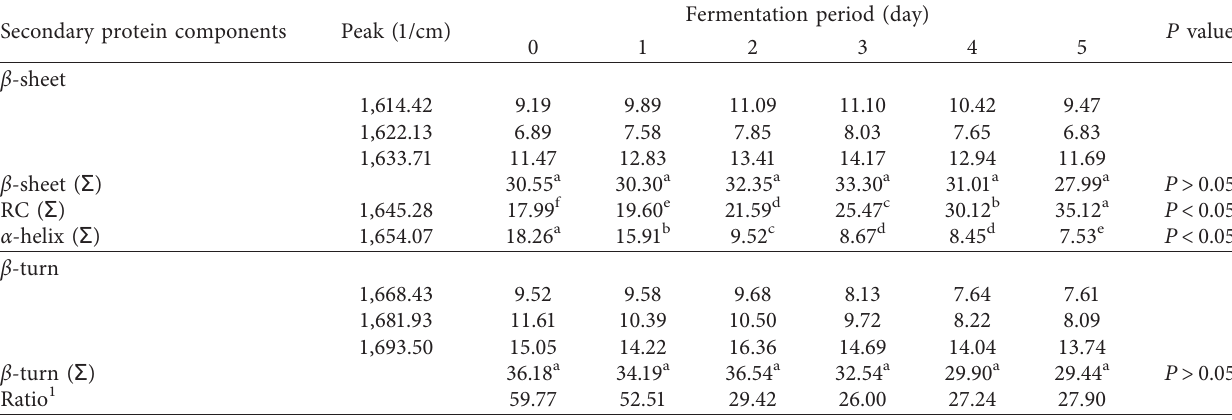
The data presented in the table represent the mean ± standard deviation ( n � 3). Values with different superscripts within the same row are statistically significant from each other ( P < 0.05). ND represents not detected. Table 3: Changes in the percentage of secondary protein components ( β -sheet, random coil (RC), α -helix, and β -turn) of unfermented